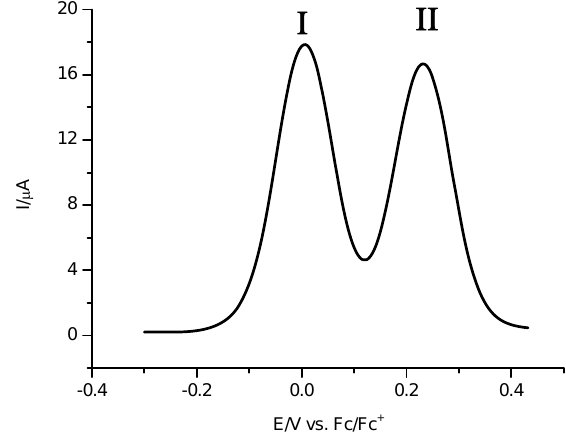
Figure 5. Square wave voltammetry obtained for 7 in the presence of 0.1 M TBABF acetonitrile. Amplitude of 50 mV with a frequency of 10 Hz and initiated from E positive direction. The working electrode used was a platinum